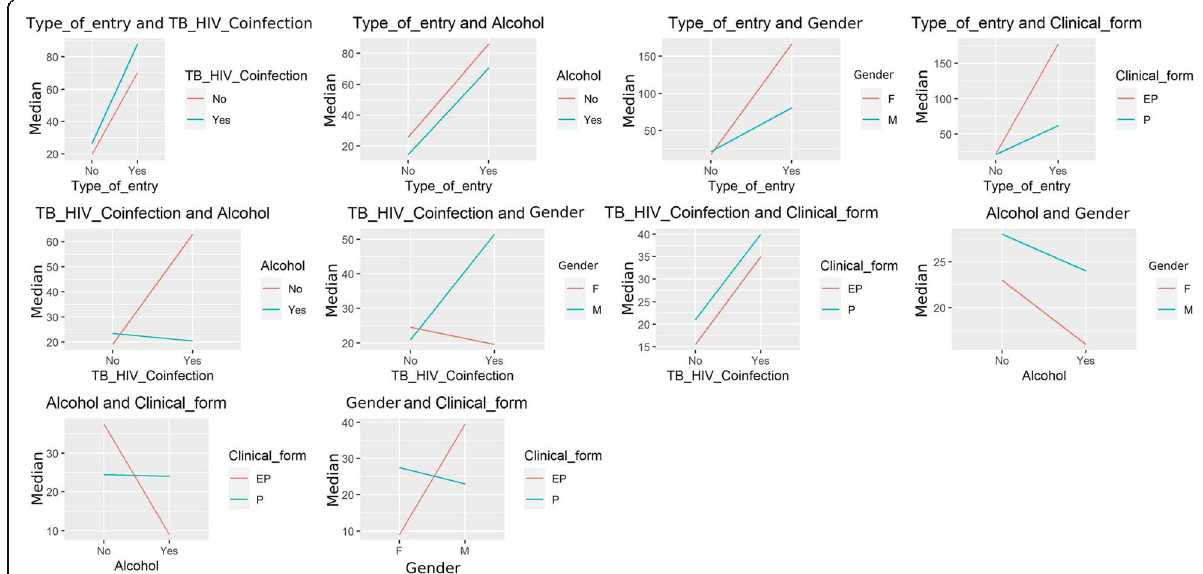
Fig. 3 Interaction plots for each pair of explanatory variables according to survival time, Curitiba-Brazil